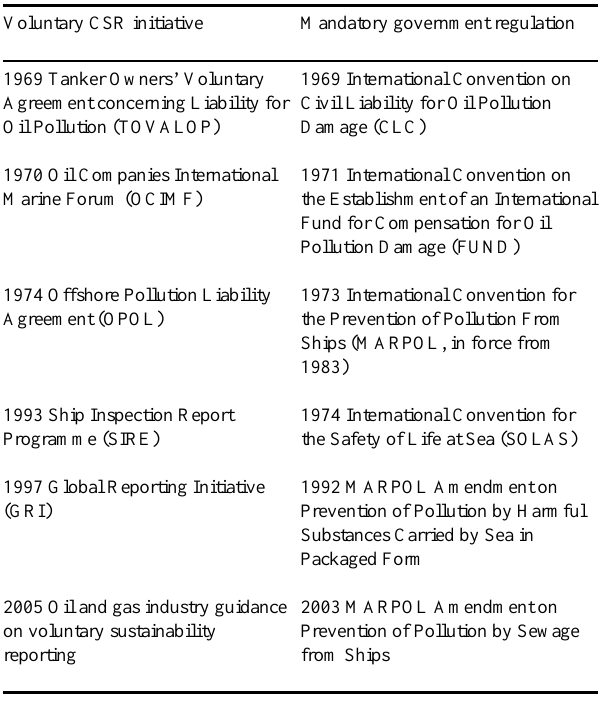
Table 1 . Timeline of key oil spill-relevant CSR initiatives and international mandatory